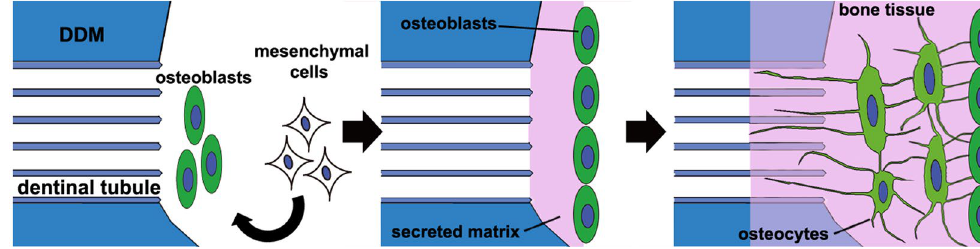
Figure 6. A schematic of the new-bone formation process after demineralised dentin matrix (DDM) substances in the DDM is type I collagen. Therefore, it is possible that the higher mineralisation around the pores of dentin tubules is caused by the DDM itself being mineralised because of the influence of the surrounding oste- oblasts and bone formation. Additionally, the intertubular dentine is mineralised by phosphophoryn, which is the most abundant NCP in dentine 18 . Finally, a new bone is formed and added around the DDM, and it is predicted that the DDM is later replaced by bone. The DDM is biocompatible and has excellent capabilities, such as osteoconduction and osteoinduction. Smith et al . reported that dentine showed antibacterial activity against three types of anaerobic bacteria associated with dental disease 19 . Homogenous and allogeneic DDM experiments report the induction of bone formation without host immune rejection 9 . In the present study, DDM transplantation after acid treatment revealed no specific presence of phagocytic cells around the DDM and new bone, despite the transplantation of human teeth into rats. The DDM was also not rejected from recipients. Kim et al . reported that osteoclasts absorb the DDM margin and show remodelling 3 . In this study, we found no evidence of osteoclast remodelling. In the future, we plan to increase the number of samples for further observation; change the experimental timing; and pursue phagocytic cells, including osteoclasts, using FIB/SEM. regeneration therapy.